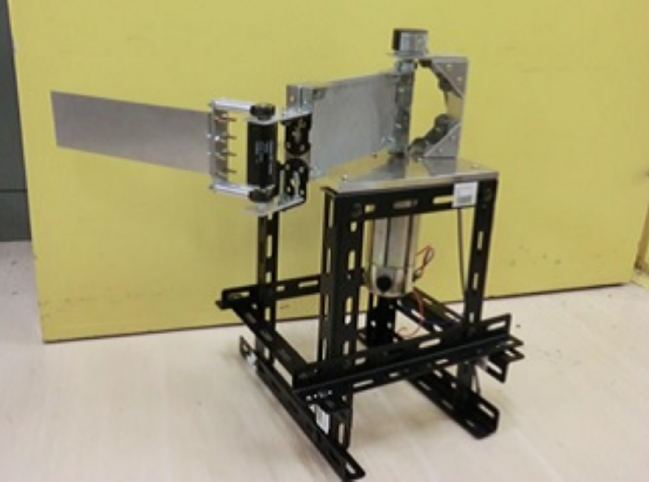
Figure 1. Robot arm used in this research (Mechanical part).